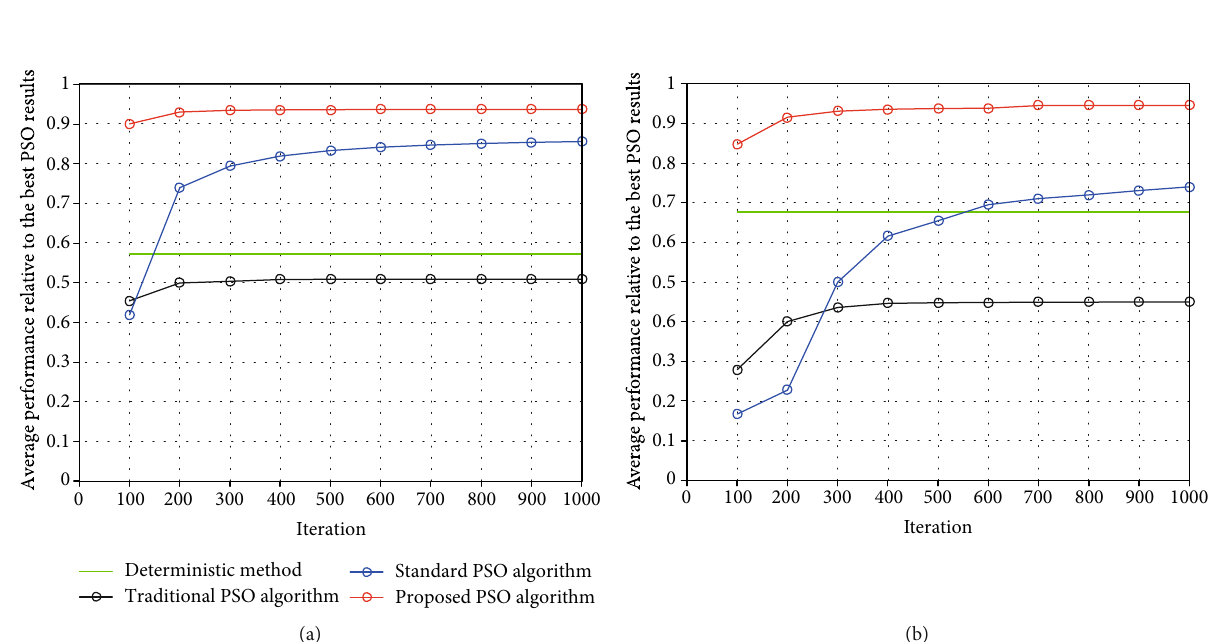
Figure 15: Average performance comparison according to the number of iterations for the short-range test cases (a) and the long-range test cases (b).